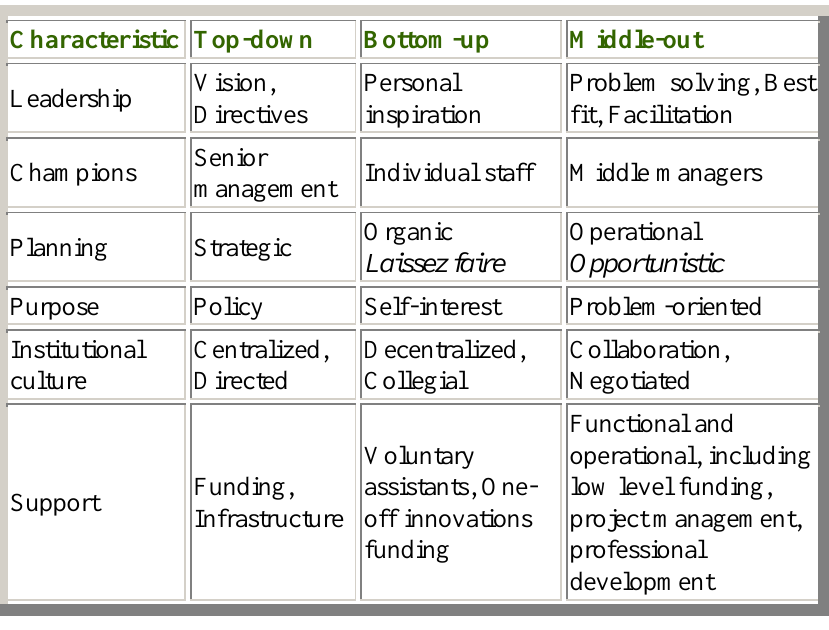
Table 1. Approaches to Innovation in Teaching and